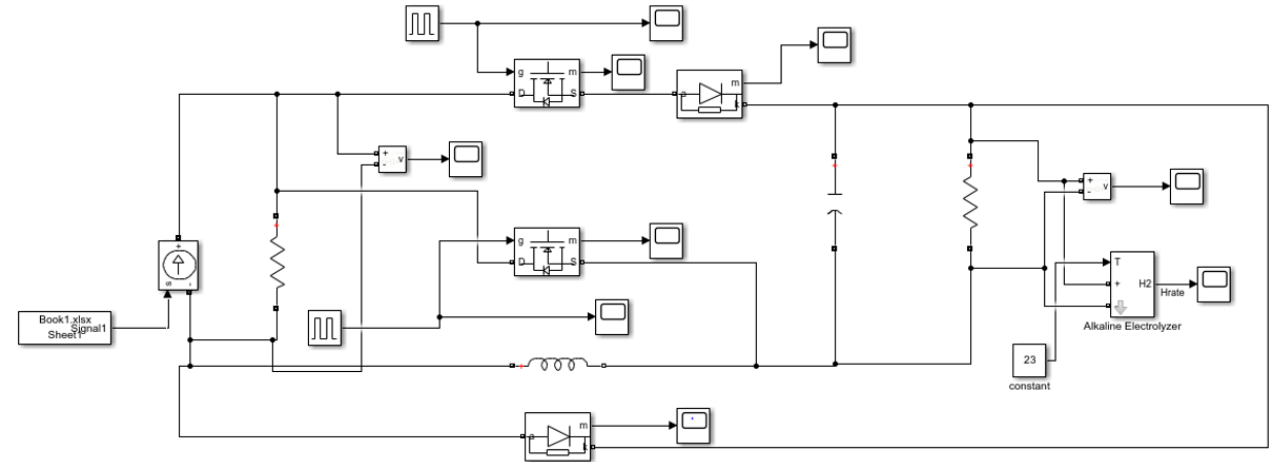
Figure 8. Demonstration of the proposed TSBB-converter experimental setup.